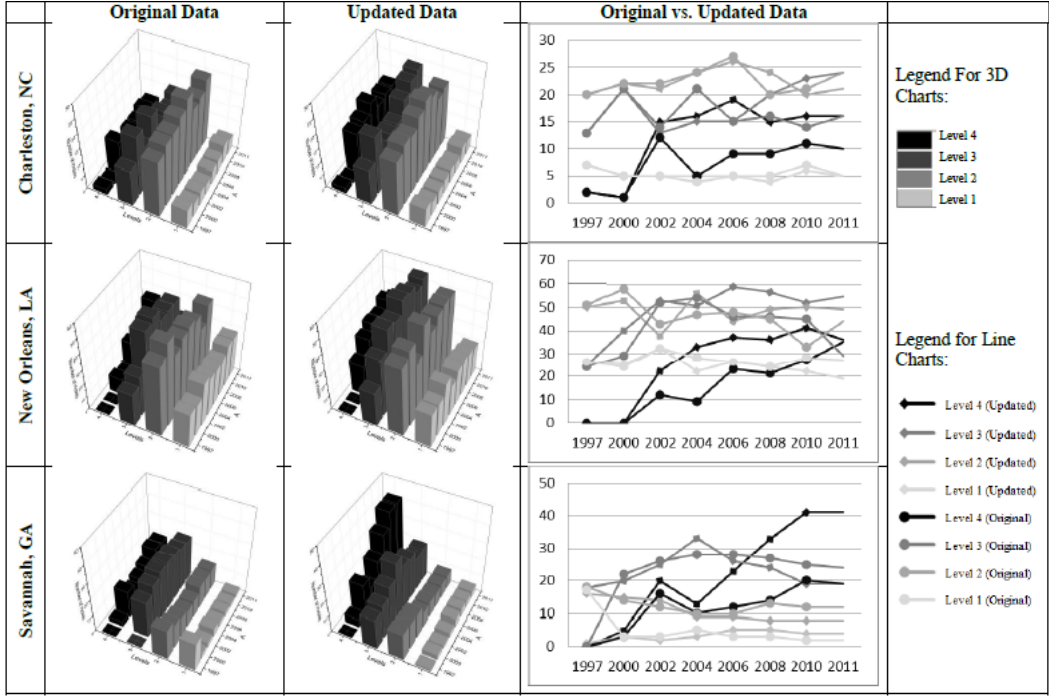
Figure 7. Comparison of hotel density over time: Original vs. updated data.